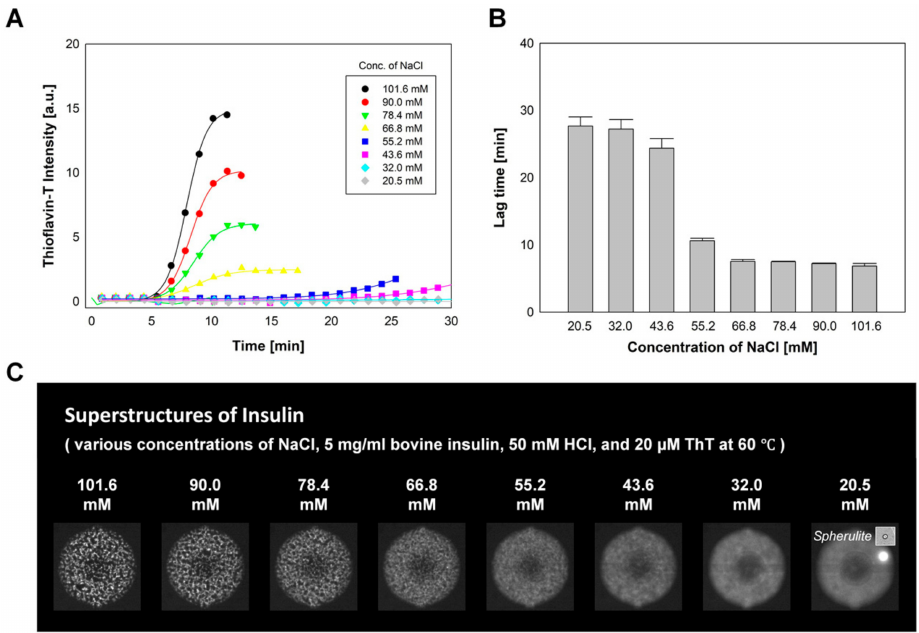
Figure 4. The e ff ect of NaCl concentration on insulin fibrillation. ( A ) The rates of insulin fibrillation and ( B ) average lag times for insulin fibril formation ( n = 8) at various NaCl concentrations (5 mg / mL bovine insulin, 50 mM HCl, and 20 µ M ThT). ( C ) Fluorescent images of insulin superstructures formed in microfluidic incubation chambers. The inset shows the bright-field microscope image of a